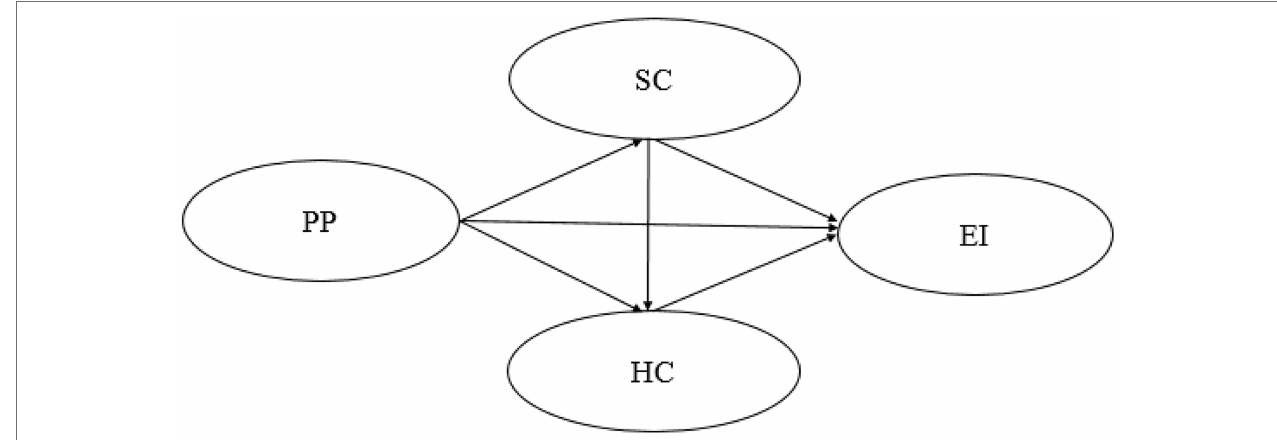
FIGURE 1 | Research framework. PP, Proactive Personality; EI, Entrepreneurial Intention; SC, Social Capital; and HC, Human